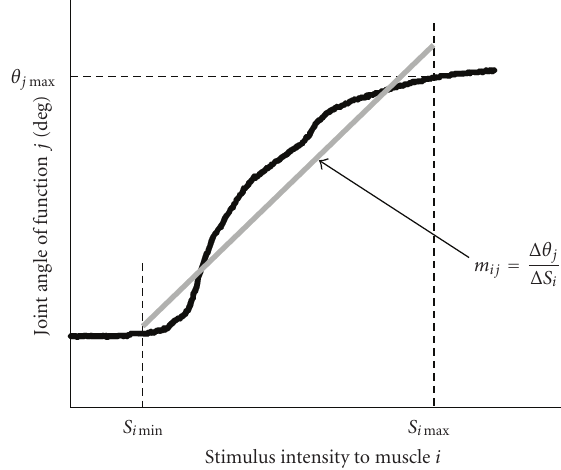
Figure 11: Outline of determination of gain of the musculoskeletal system. The gray solid line shows the approximated linear line of the input-output relationship of the